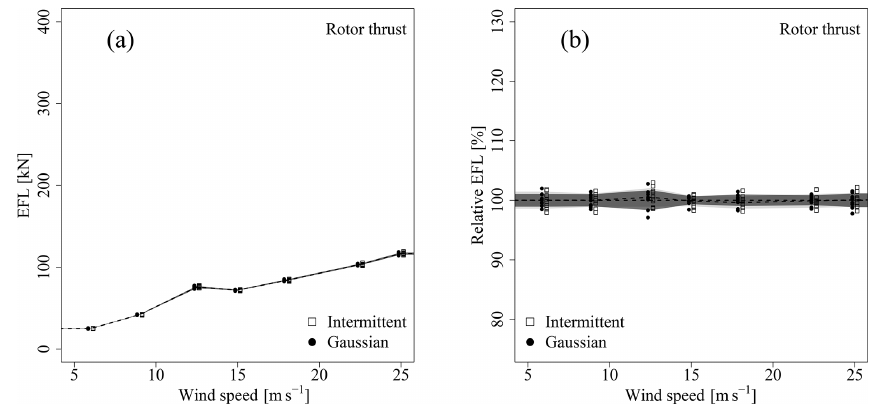
Figure 9. EFL for the rotor thrust for the delta-correlated case. The figure is analogous to Fig. 7.